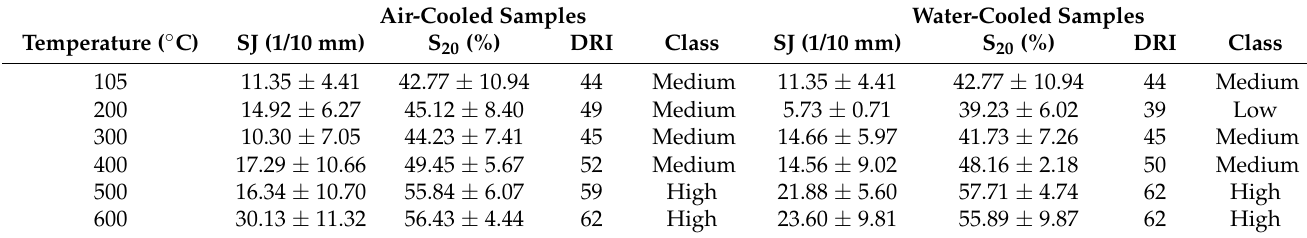
Table 2. Variation with temperature of Siever’s J miniature drillability test (SJ), brittleness test (S 20 ), and drilling rate index (DRI) final value and for air- and water-cooled